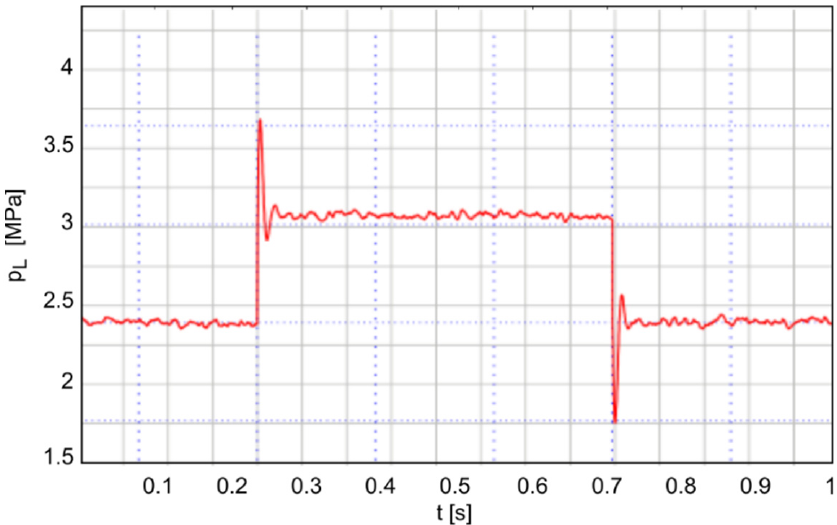
Figure 23. Characteristics of instantaneous pressure shock in the HSD-SDD system. The experimental test confirmed the effectiveness of the discrete LQG controller in controlling the SHA-HSD system because there was no need to correct robot levelling during the bricklaying